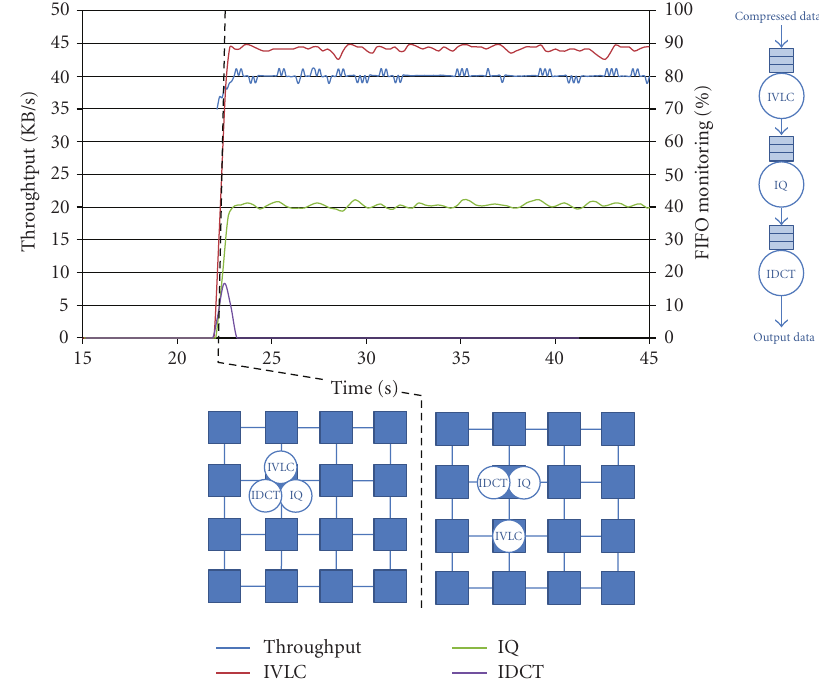
Figure 22: MJPEG execution in